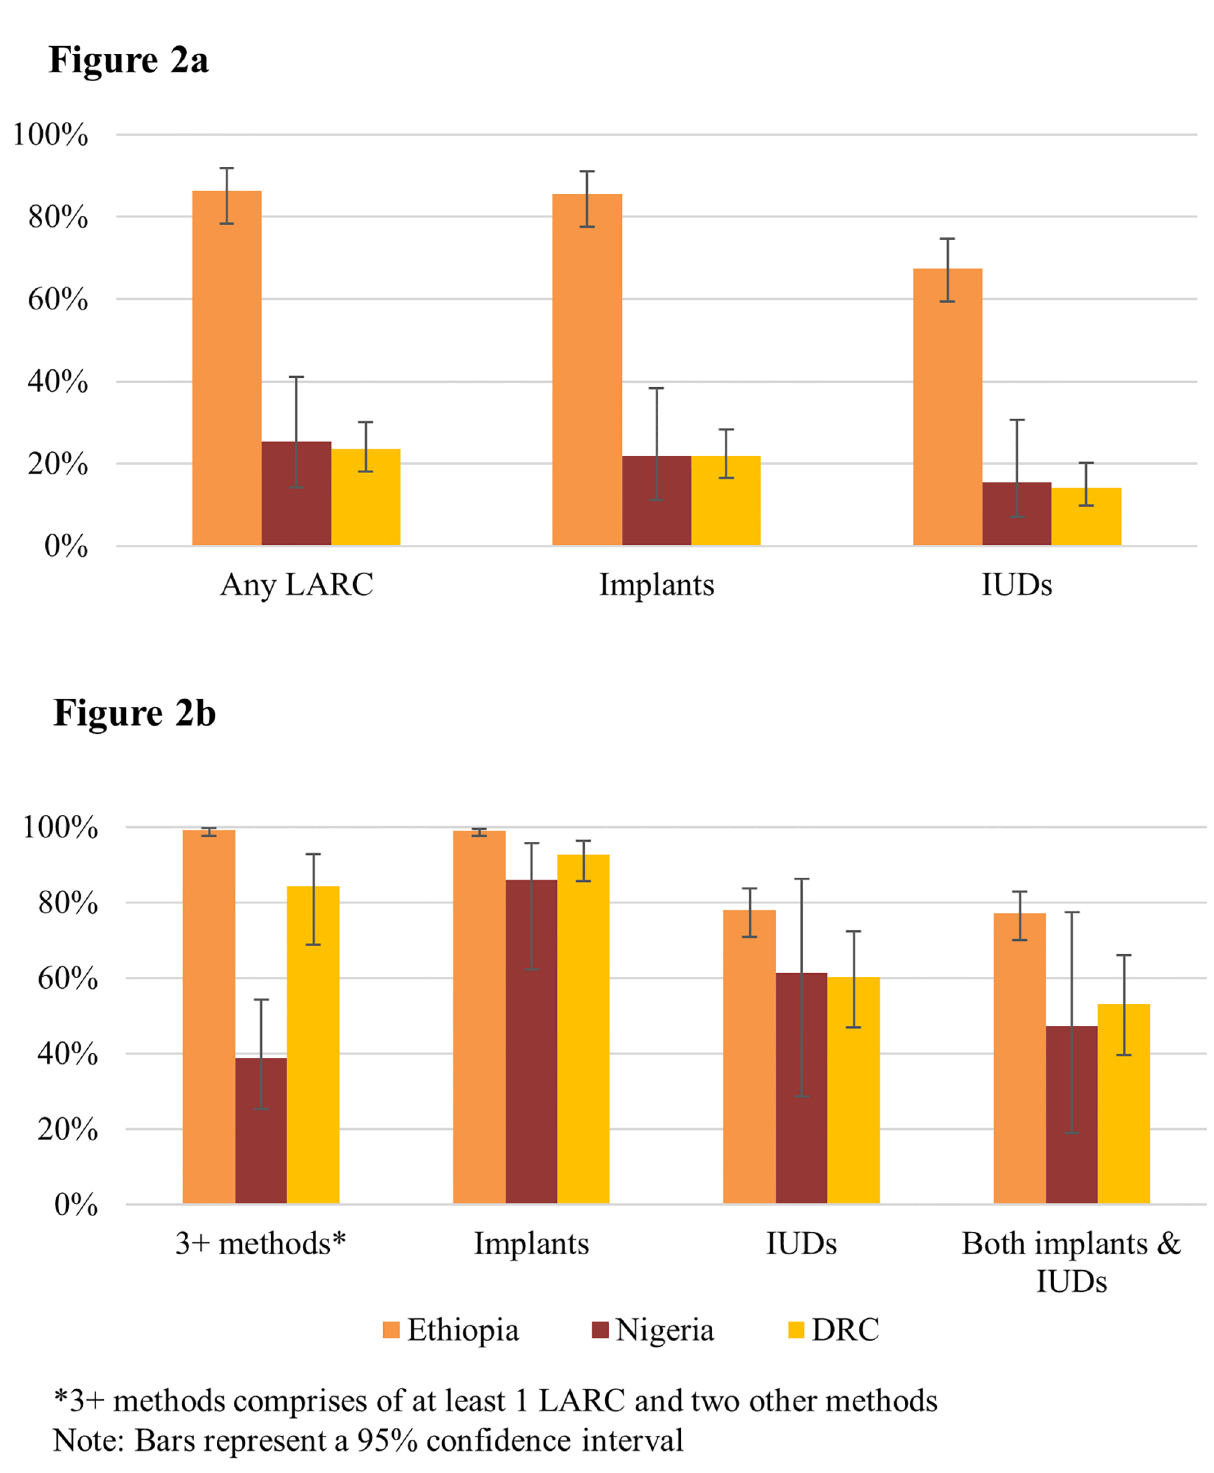
Fig 2. a: Method availability, among all public health facilities. b. Method diversity, among public health facilities with at least 1 LARC.